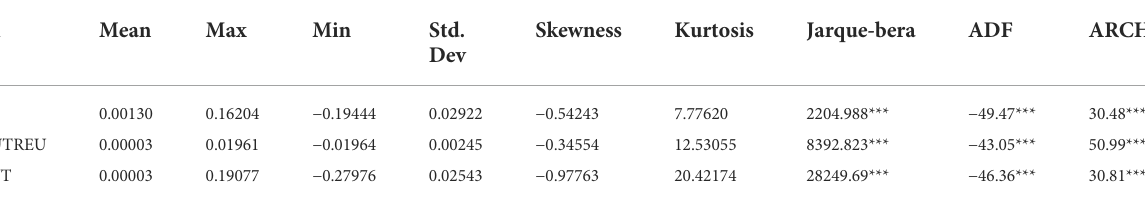
TABLE 2 Summary statistics of daily returns.